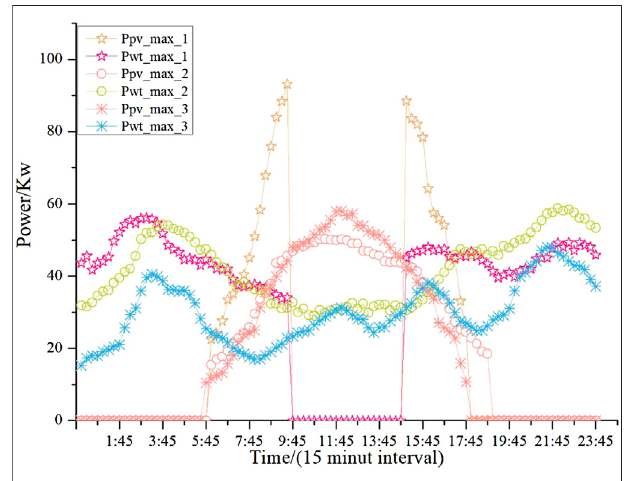
FIGURE 4 | 15 min active power demand curve. FIGURE 5 | Output curve of the 15 min PV and WT.